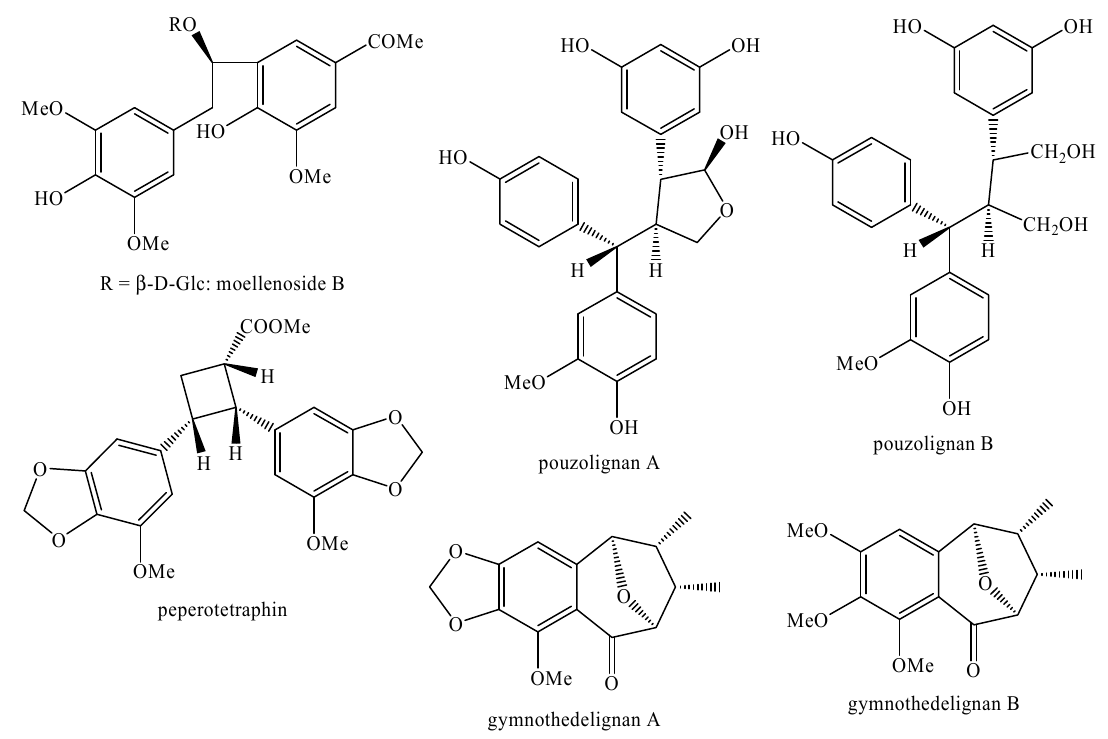
Figure 13. Isolated nor -lignans in the plant kingdom—part 12.